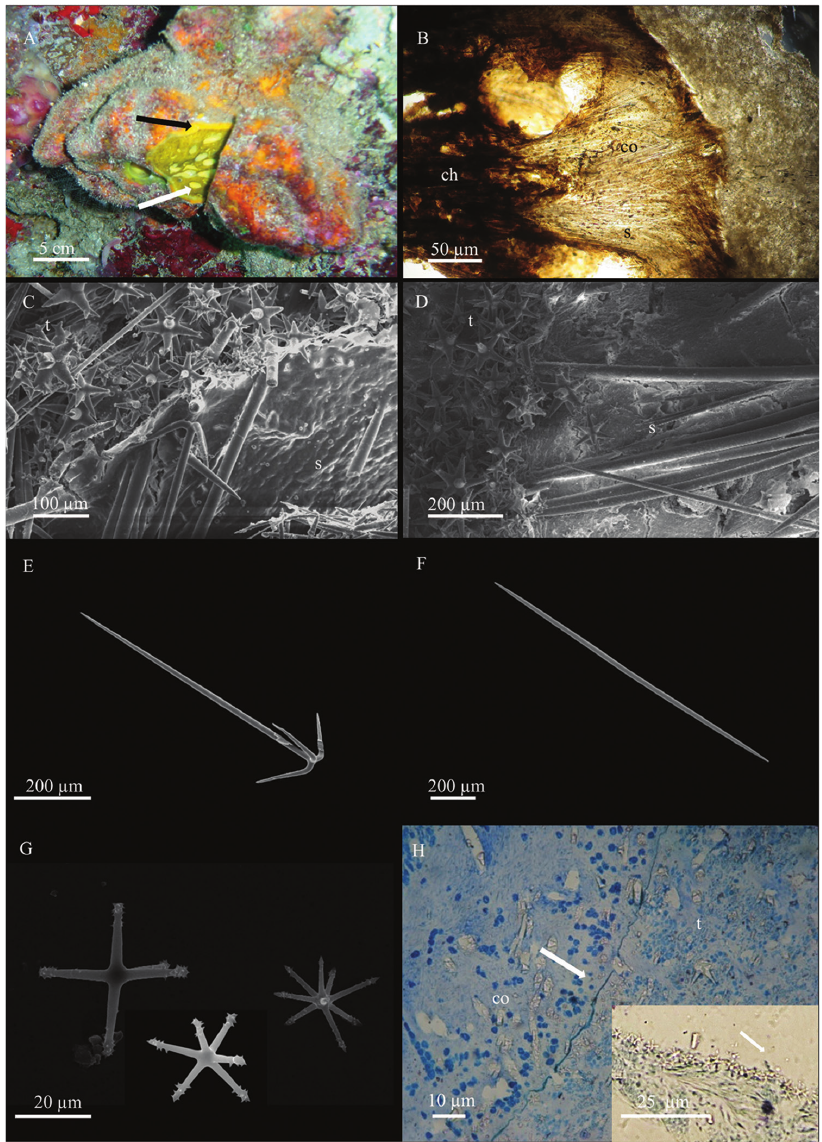
Figure 4. Stelletta tethytimeata sp. n. A specimen in situ (BU-533), partially cut to put in evidence the association with Tethytimea tylota . The black arrow indicates the thin layer of the external sponge ( T. tylota , orange) while the white arrow indicates S. tethytimeata sp. n. B paraffin-embedded section of T. tylota ( t ) and S. tethytimeata sp. n. ( s ) co and ch indicate, respectively, the cortex and the choanosome of S. tethytimeata sp. n. C cross section showing triaenes close to the boundary between T. tylota ( t ) and S. tethytimeata sp. n. ( s ) D bundles of oxeas reaching the boundary between T. tylota ( t ) and S. tethytimeata sp. n. ( s ) E anatriaene F oxea G micrasters H histological preparation showing the cortex ( co ) of S. tethy- timeata sp. n. The arrow points to the collagenous layer between S. tethytimeata sp. n. and T. tylota ( t ). The inset shows the layer of tylasters of T. tylota